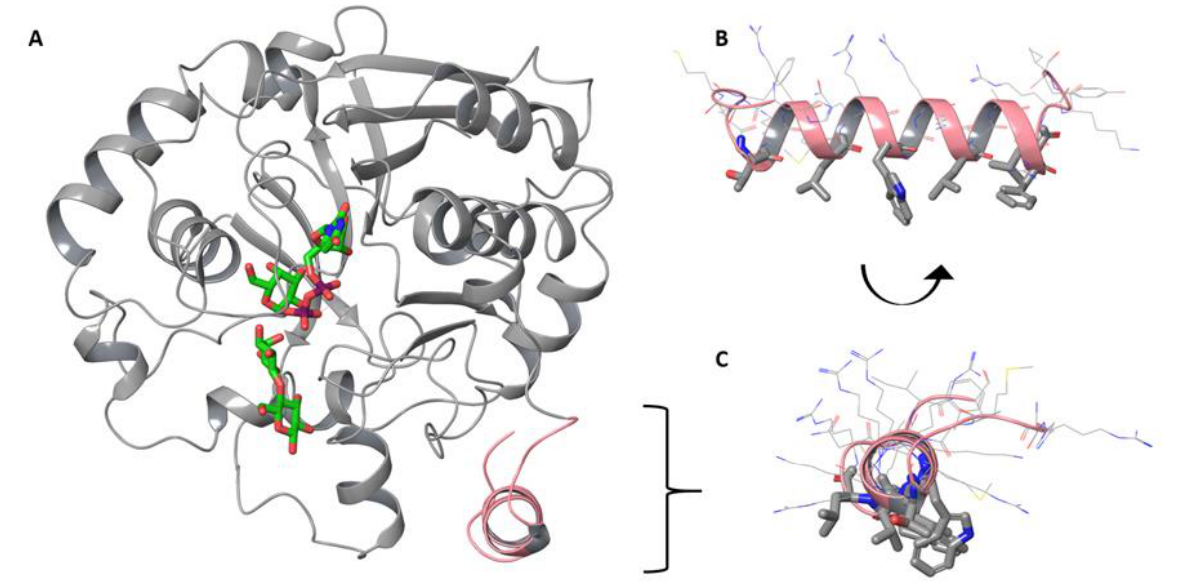
Figure A1. ( A ) The model of full-length LgtC predicted by AlphaFold2 with UDP-Gal and lactose obtained from 1GA8. ( B , C ) The C-terminal α -helix given in pink color with hydrophobic residues shown in thick lines. Color coding: grey for C atoms of the protein, green for C atoms of the ligands, blue for N atoms, red for O atoms.